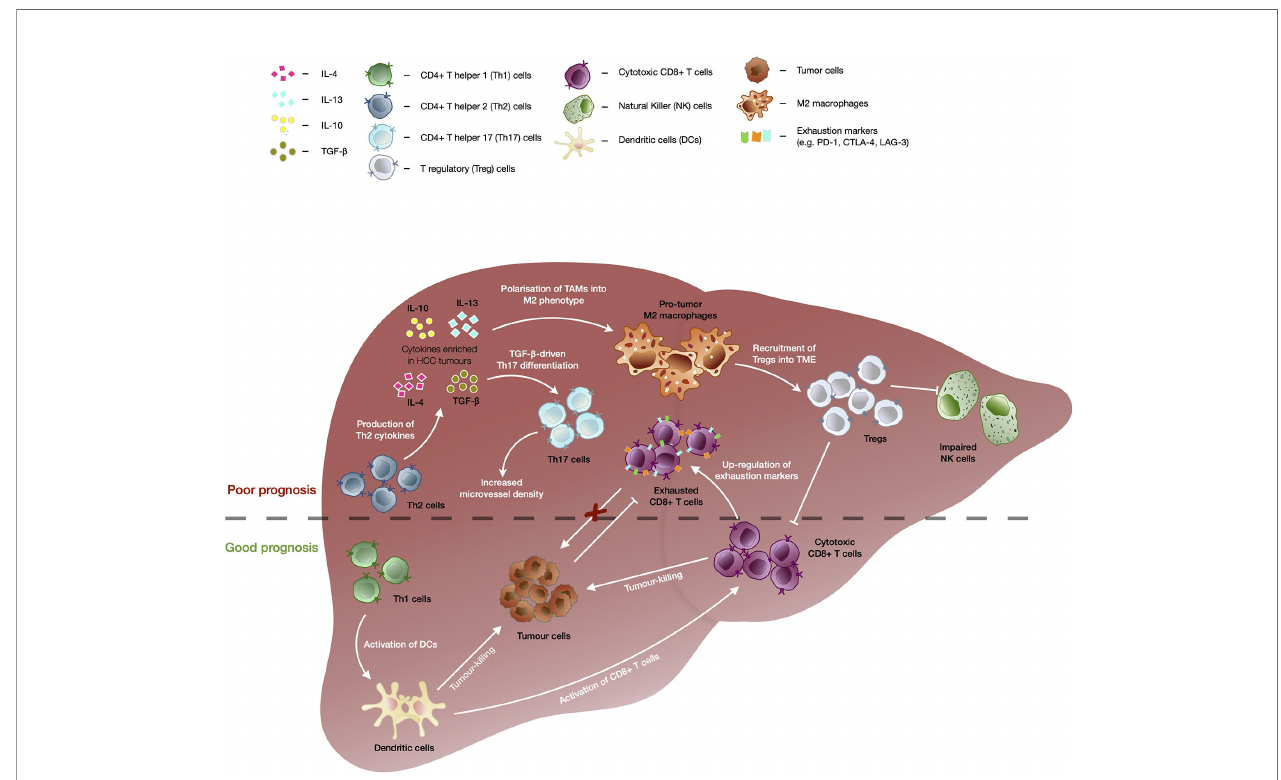
FIGURE 1 | The immunological events contributing to good versus bad prognosis in HCC. Enrichment of CD4+ T helper 2 (Th2) cells are associated with poor overall survival of HCC patients. TGF- b as well as cytokines secreted by Th2 such as IL-4, IL-10, and IL-13, drives the polarization of tumor-associated macrophages (TAMs) into immunosuppressive M2 macrophage phenotype which further recruits T regulatory cells (Tregs). Tregs in turn further enhances the immunosuppressive tumor microenvironment through inhibition of CD8+ T memory/effector cells ’ and natural killer (NK) cells ’ tumor-killing capacity, leading to poor prognosis in HCC. TGF- b also drives differentiation of CD4+ T helper 17 (Th17) cells and high frequencies of Th17 have been correlated with increased microvascular invasion and shorter OS and DFS of HCC patients. Presence of CD4+ T helper 1 (Th1) cells correlated with favorable outcomes in HCC as they are able to enhance activation of CD8+ T cells via dendritic cells (DC) and trigger DC-mediated tumor-killing. Despite the capability to kill tumor cells and association with good prognosis in HCC, CD8+ T cells showed upregulation of exhaustion markers (e.g. PD-1, CTLA-4, and LAG-3), which dampens its killing capacity in chronic conditions leading to tumor